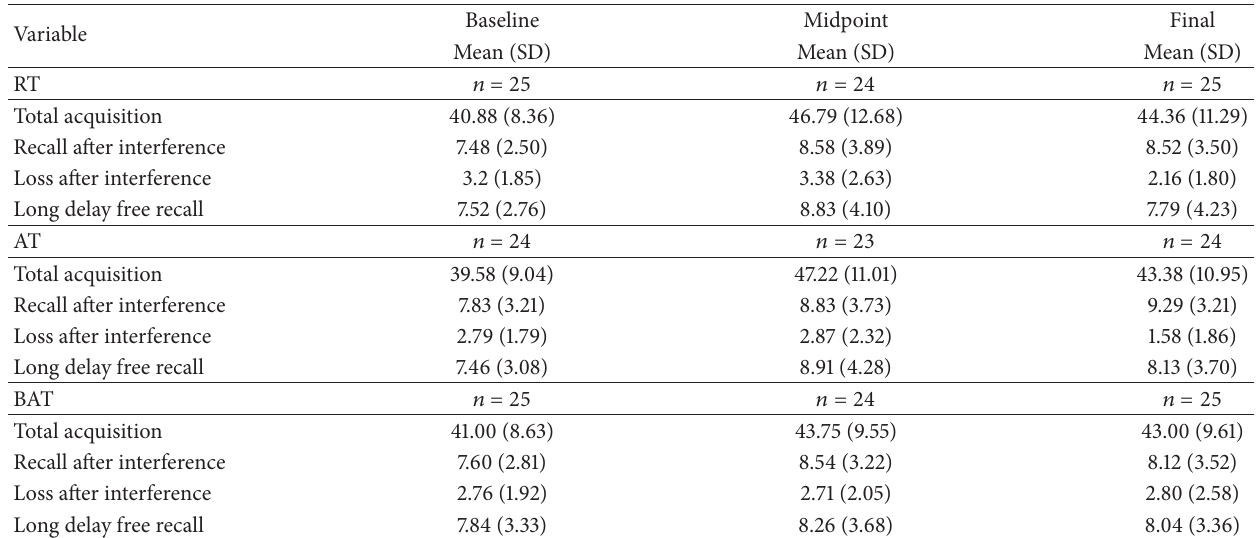
Table 2: Mean values (SDs) for RAVLT performance.